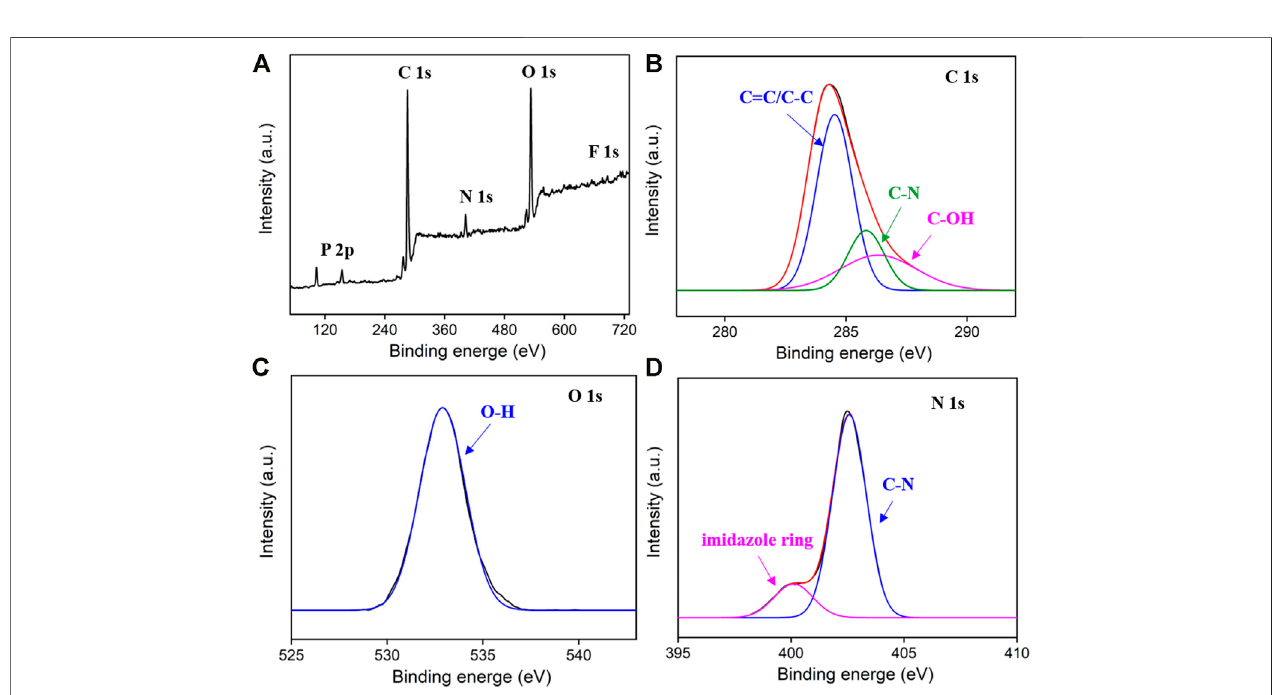
FIGURE 3 | The XPS survey spectrum (A) and high-resolution spectra C1s, (B) O1s, (C) and N1s (D) of IL-GQDs.